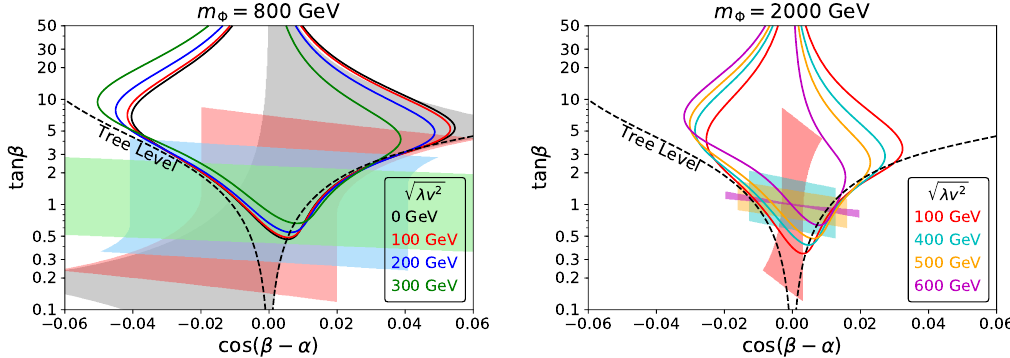
Figure 5 . Allowed region from three-parameter (cid:12)tting results at 95% C.L. in the cos( (cid:12) plane with varying p (cid:21)v 2 under CEPC precision. m (cid:8) is set to be 800 GeV (left) and 2000 GeV (right). For each p (cid:21)v 2 , we show the (cid:31) 2 (cid:12)t result with colored solid lines and the same color shaded region preferred by theoretical constraints. As a comparison, tree-level (cid:31) 2 (cid:12)tting result is shown by dashed black